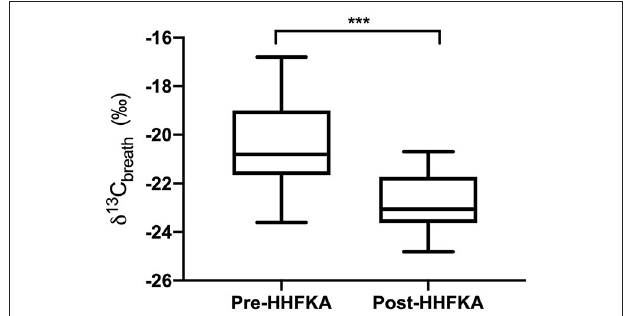
FIGURE 2 | After lunch carbon isotope values of exhaled breath display differences pre- and post HHFKA. Box and whiskers plot of carbon isotope values of exhaled breath CO 2 collected after lunch from high school students (grades 10-11) before the Healthy, Hunger Free Kids Act (31); Pre-HHFKA, n = 33 and after Post-HHFKA, n = 24. *** p < 0.001, unpaired t